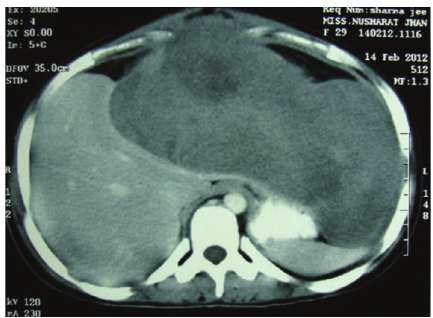
Figure 3: Relationship of mass with liver (black arrow indicates tumour-liver interface).